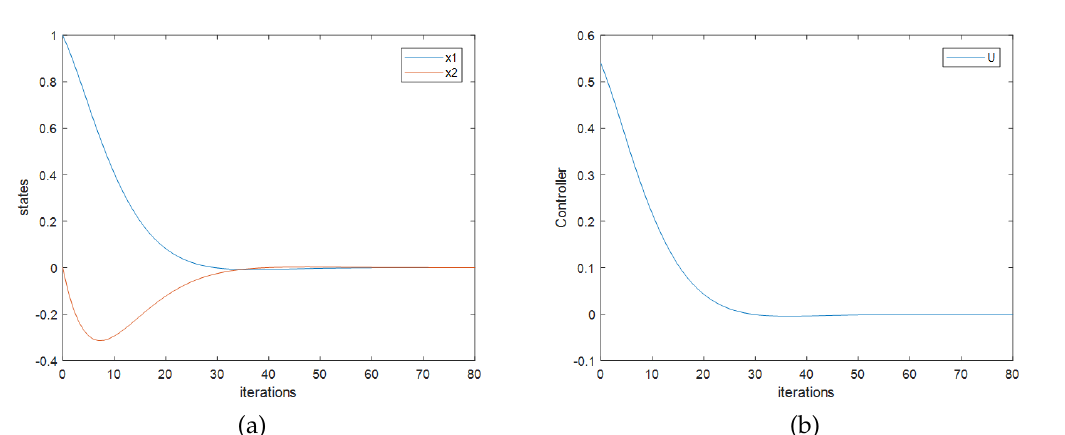
Figure 1. Closed-loop response and the control effort of system 2. ( a ) Trajectories of state values. ( b ) Trajectory of control